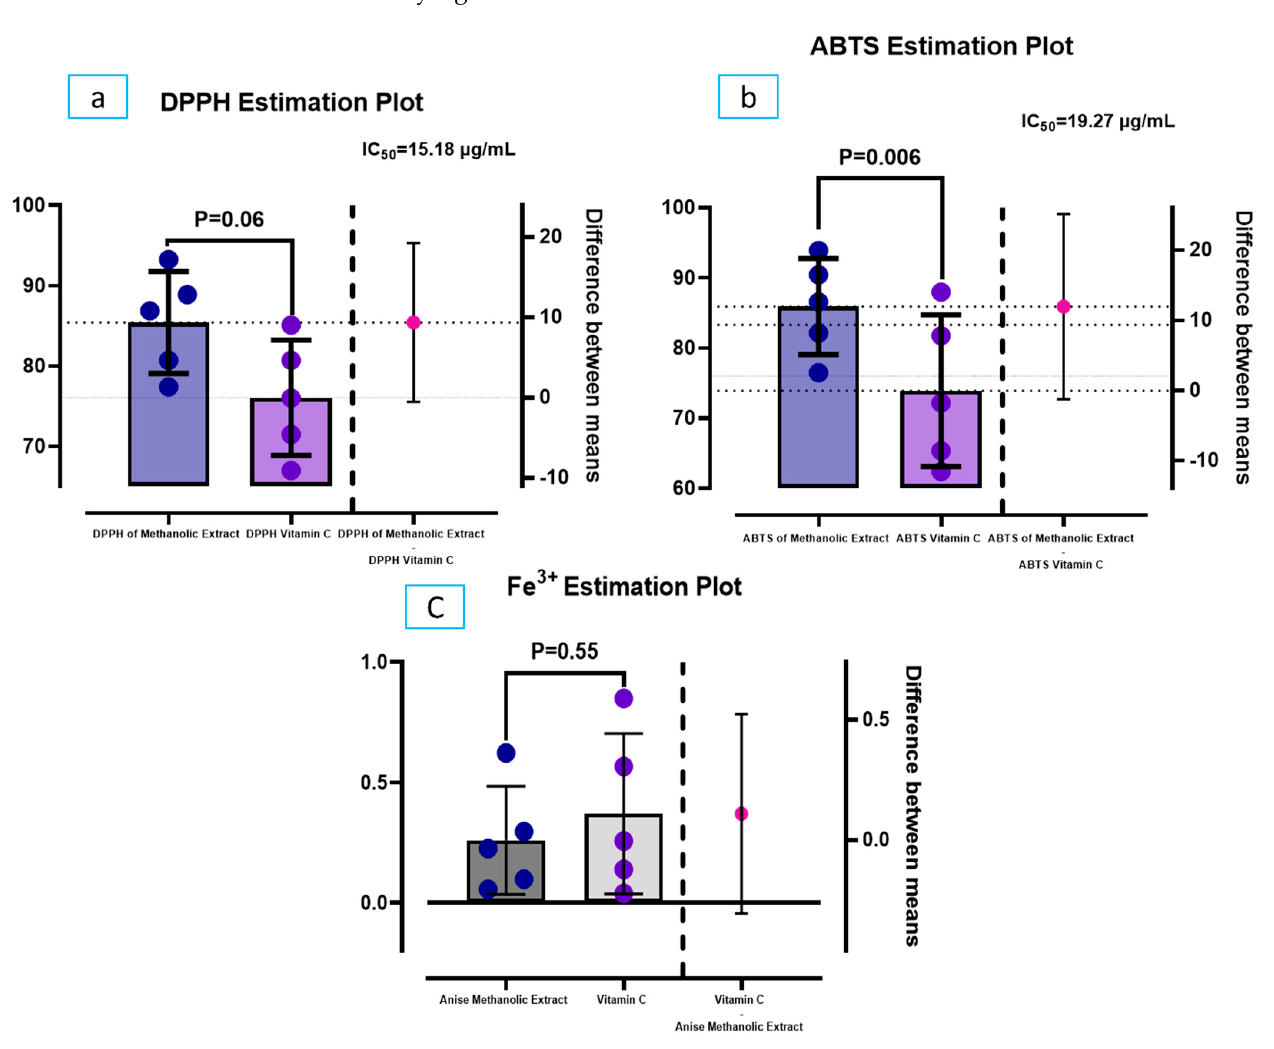
Figure 7. ( a ) DPPH scavenging assay of aniseed methanolic extract and Vit C. ( b ) ABTS scavenging assay of aniseed methanolic extract and Vit C. ( c ) Reducing power scavenging assay of aniseed methanolic extract and Vit C. Results are mean ± SD of five equivalent measurements. Experiment was carried in triplicate. p value < 0.05 when compared to Vit